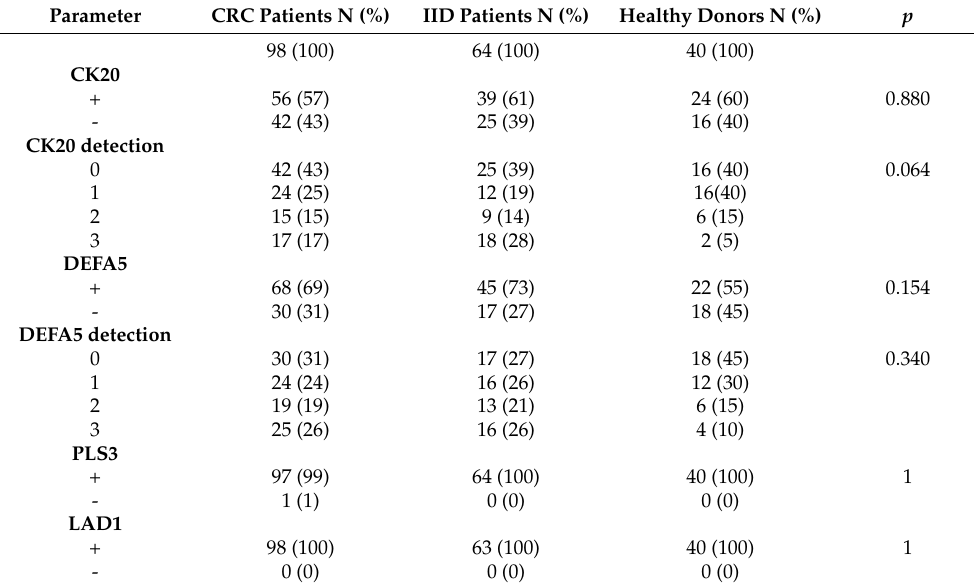
Table 2. Detection rate of CTC-associated marker sCK20, DEFA5, PLS3, and LAD1 in MNC-derived RNA from blood samples of CRC and IID patients as well as healthy